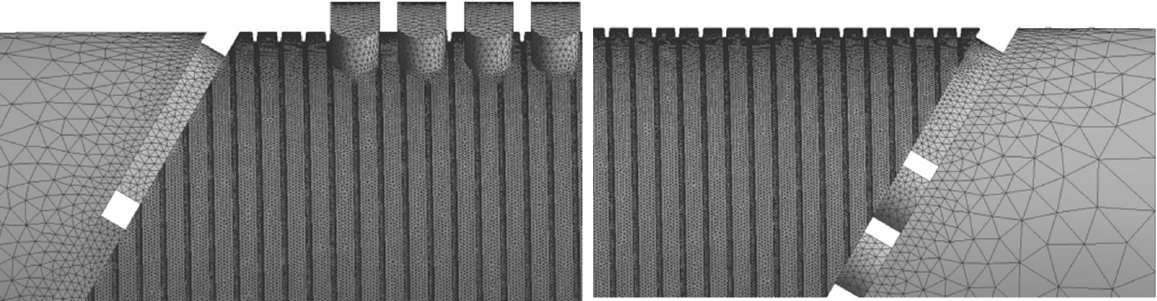
Forests 2022 , 13 , x FOR PEER REVIEW Figure 4. Local grid distribution in the fluid domain. Figure 4. Local grid distribution in the fluid domain.